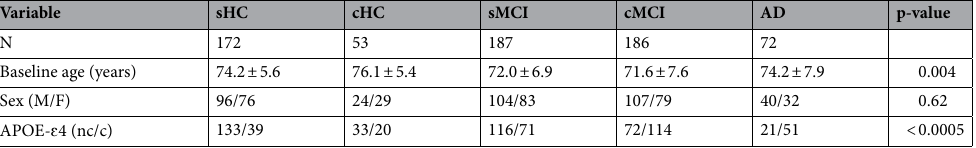
Table 3. Characteristics of the balanced longitudinal ADNI sample used. Baseline age values are in mean ± standard deviation. M = male, F = female, nc = non-carriers, c=carriers. p-values indicate differences between group. We used ANOVA for baseline age, and Fisher’s exact test for the other